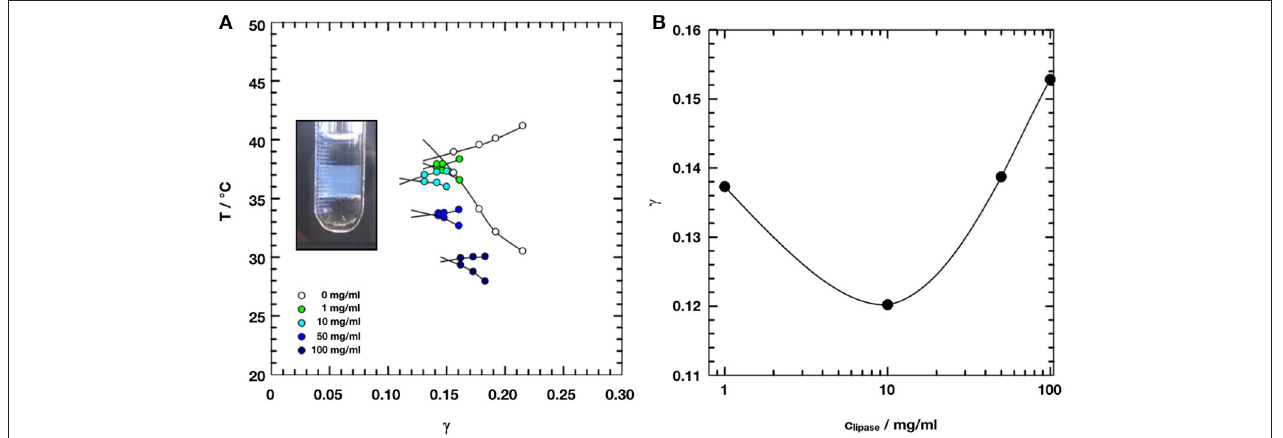
FIGURE 1 | (A) Phase diagrams of microemulsions of type H 2 O/NaCl (0.4wt%)– n -octane–C 10 E 5 –lipase Candida antarctica B at equal volume fractions of water and oil φ 0.50 with increasing concentration of lipase from 0 to 100 mg/ml referred to the water phase. Adapted with permission from Subinya et al. (2014), Copyright = 2014 American Chemical Society. (B) X-points of the respective microemulsions as a function of lipase concentration. At 10 mg/ml of lipase, the efficiency of the microemulsion runs through a